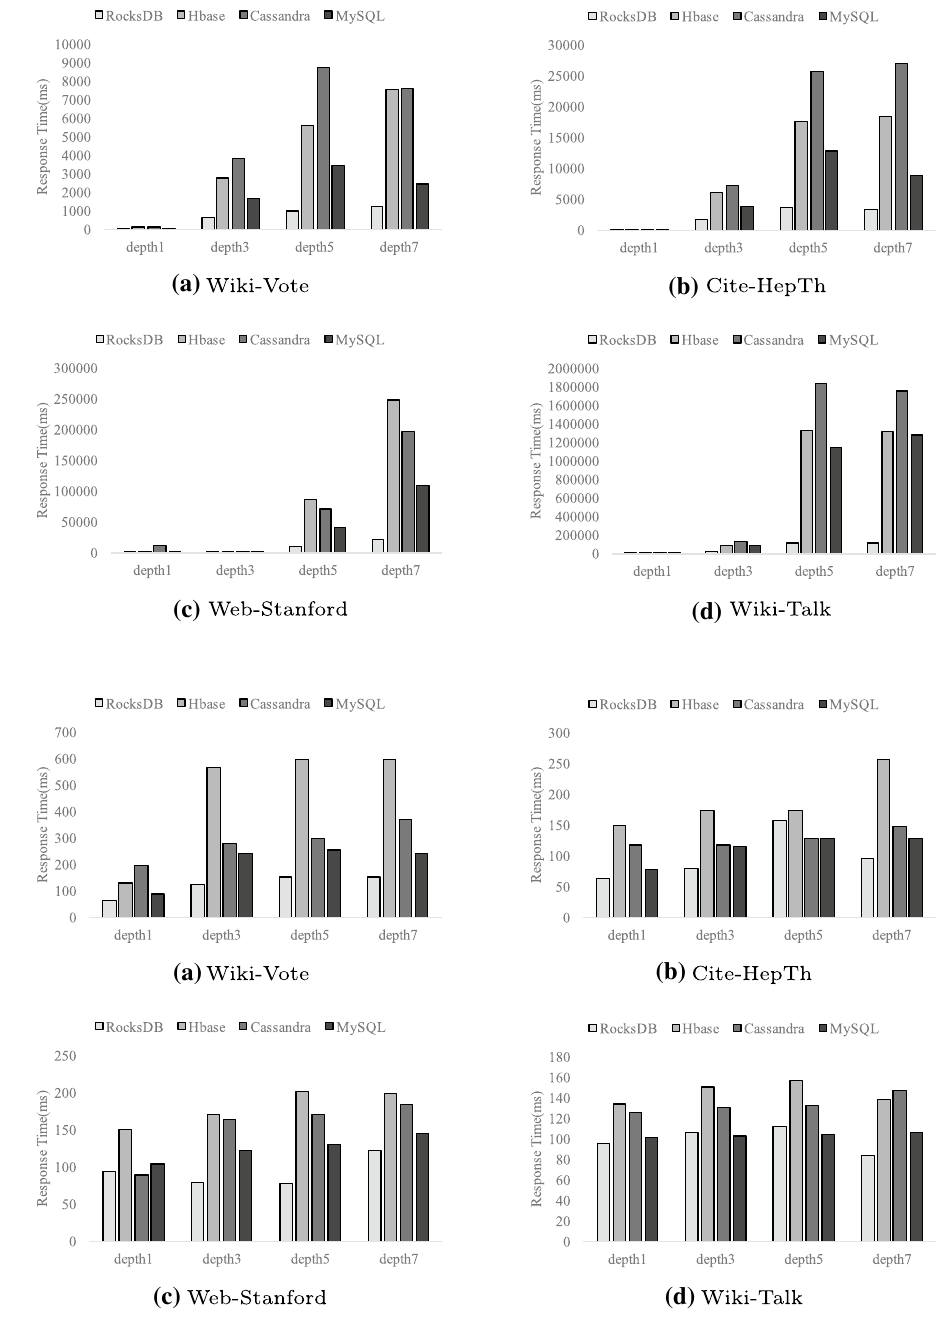
Fig. 5 Testing the K-neighbor algorithm over 4 back-end stor- age engines